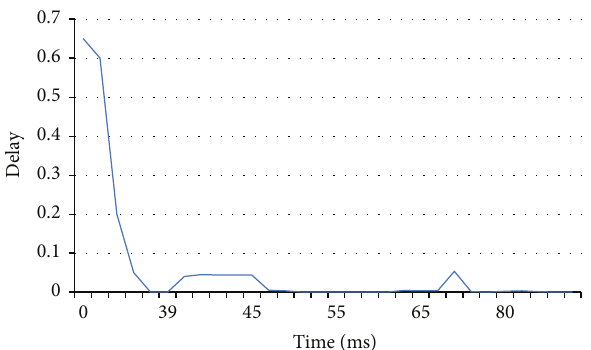
Figure 4: System delay for 4 legitimate nodes and 1 jammer.